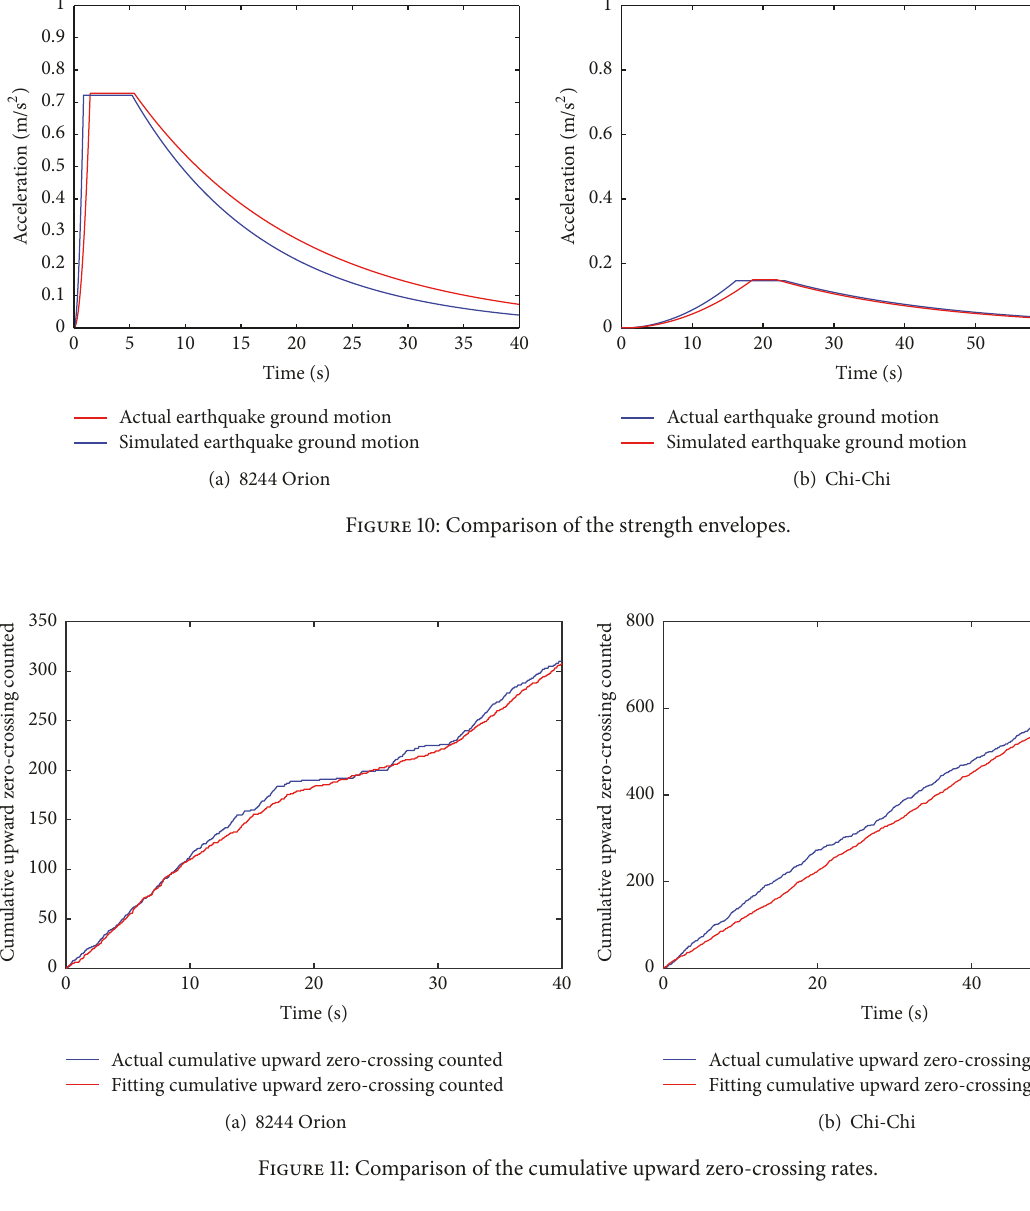
Figure 11: Comparison of the cumulative upward zero-crossing